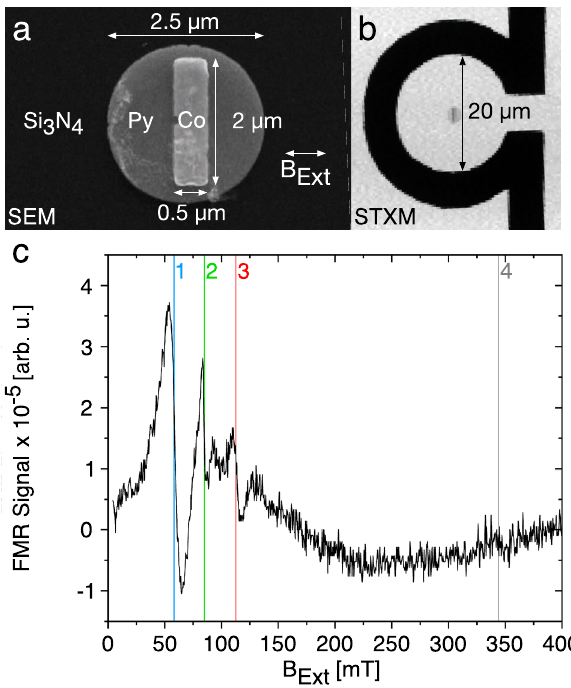
Figure 1. ( a ) Scanning electron microscopy (SEM) image of the Co stripe/Py disk bilayer on a Si 3 N 4 membrane. The orientation of B ext is indicated; ( b ) STXM image of the sample in the micro-resonator loop; The high-frequency magnetic field oscillates in the out-of-plane direction ( c ) FMR spectrum of the sample shown in a) with four major resonances, 1: Py resonance, 2: Coupled resonance, 3: Co stripe center resonance, 4: Resonance of the long sides of the Co